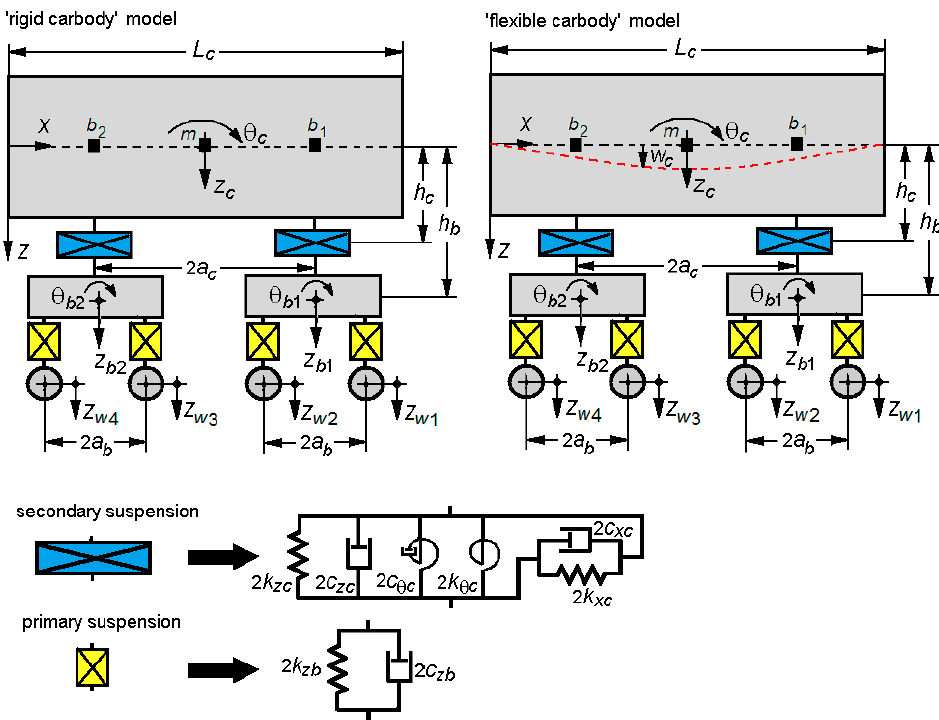
Figure 1. Model of the vehicle: ‘rigid carbody’ model; ‘flexible carbody’